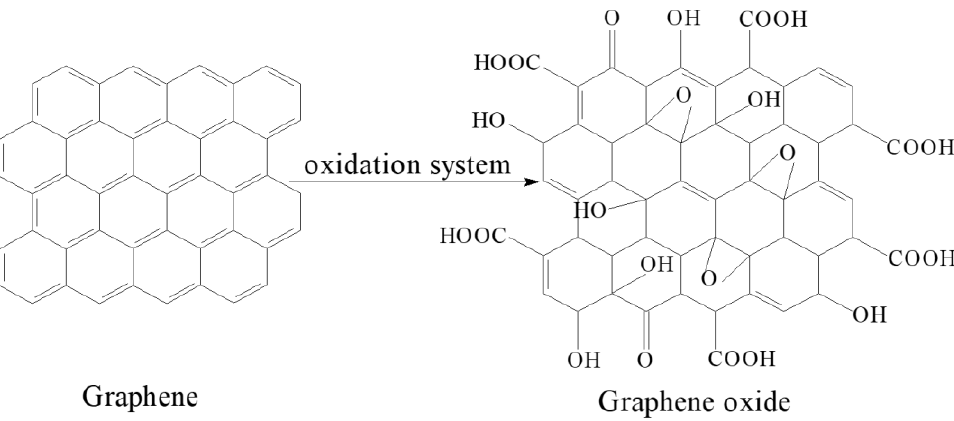
Figure 1. Structure schematic of graphene and graphene oxide.